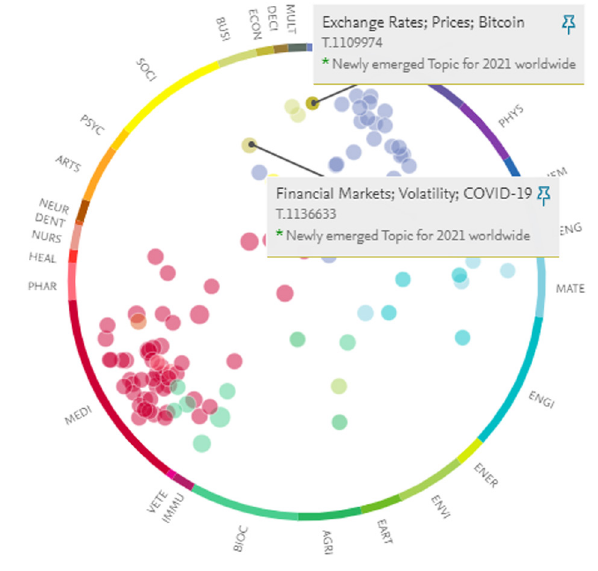
Figure 2. Newly emerged topics for SDG 3 in 2021